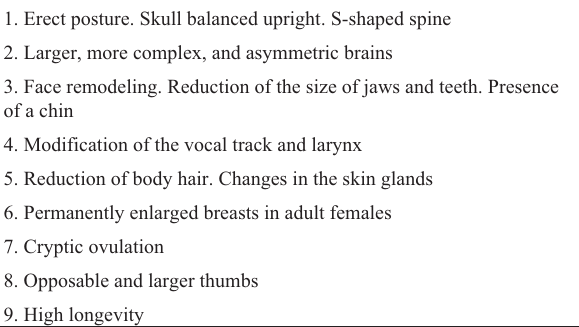
Table 1 - Selected anatomical and physiological differences between hu- mans and other primates.